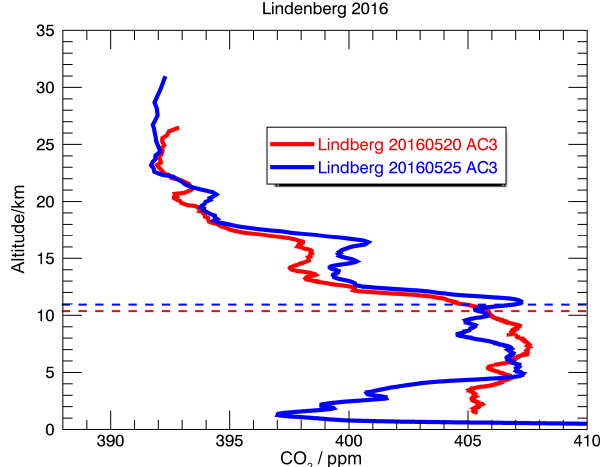
Figure 9. Vertical profiles of CH 4 derived for the flights on 20 and 25 May 2016 from Lindenberg in Germany. The flight on 25 May reached higher altitudes due to use of a larger balloon. The dashed lines represent the thermal tropopause according to the WMO defi- nition.